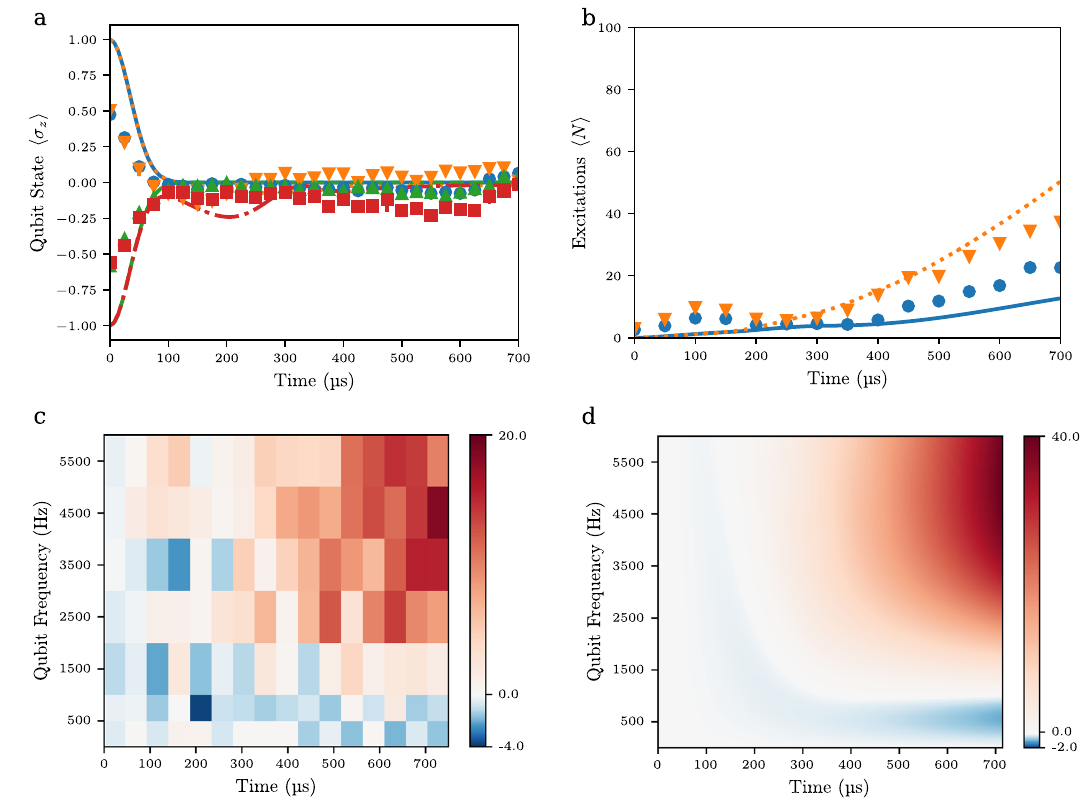
Fig. 4 | Preparing atoms in qubit states. a Time evolution of the qubit excitation (cid:7) (cid:8) σ following preparation of atoms in lower (orange triangles) and upper (red z squares) states of the two-state system for a qubit spacing ω q comparison, the blue dots and green upside-down triangles correspond to mea- surements with ω q = 0. The lines are theory. g ω =6 : 50 5 ð Þ in all measurements. b Variation of the mean excitation number <N>on the interaction time for atoms